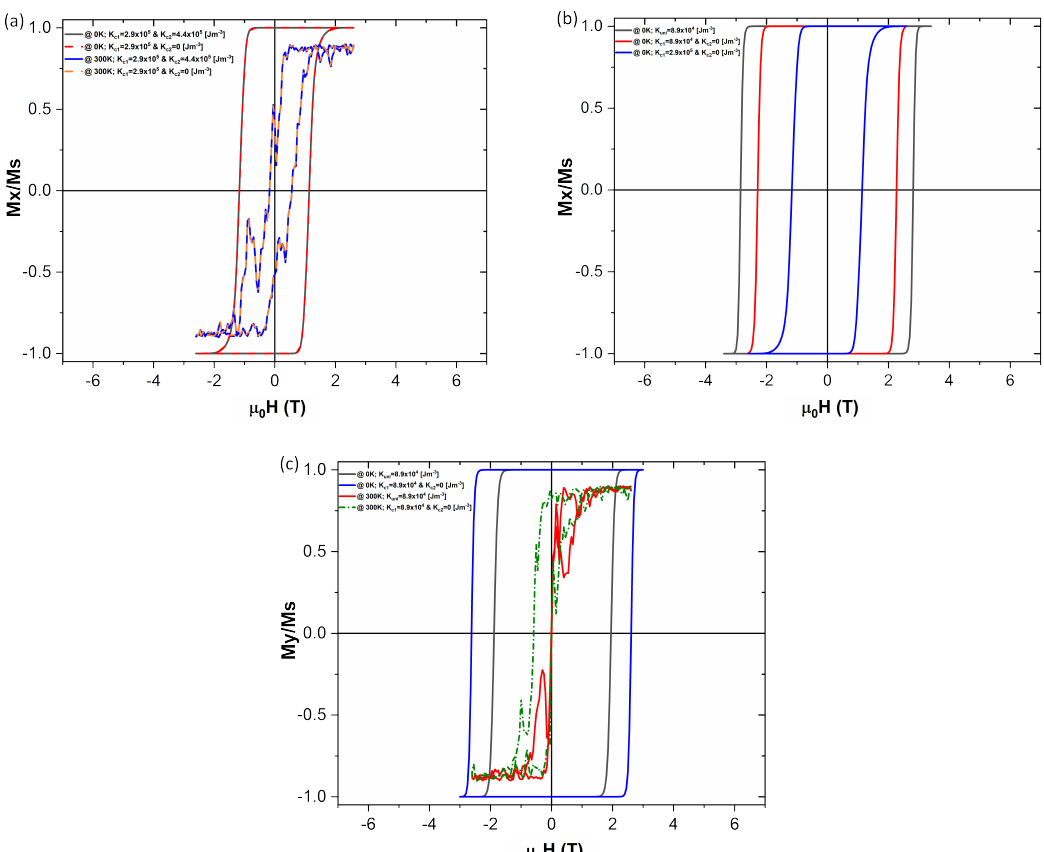
Figure 7. Comparison between cubic and uniaxial anisotropies. ( a ) Using first and second order cubic anisotropy constants, K c 1 and K c 2 respectively, where the easy anisotropy axis and H ext are applied in the same v (1,0,0) direction. In both 0 K and 300 K there is no real benefit in using the second order term, K c 2 . ( b ) For the constants values K c 1 = K uni , the simulation when just using the cubic anisotropy presents a coercive field ≈ 0.55 T lower than when just using the uniaxial one, being the H ext applied along the same (1,0,0) anisotropy easy direction. The coercivity gets further reduced with a higher magnitude anisotropy constant. ( c ) When the external field, H ext , is applied along the (0,1,0) direction (which is perpendicular to the anisotropy one (1,0,0)), the coercive field for the cubic anisotropy is now ≈ 0.70 T higher than the uniaxial anisotropy one. This trend is seen both at 0 K and 300